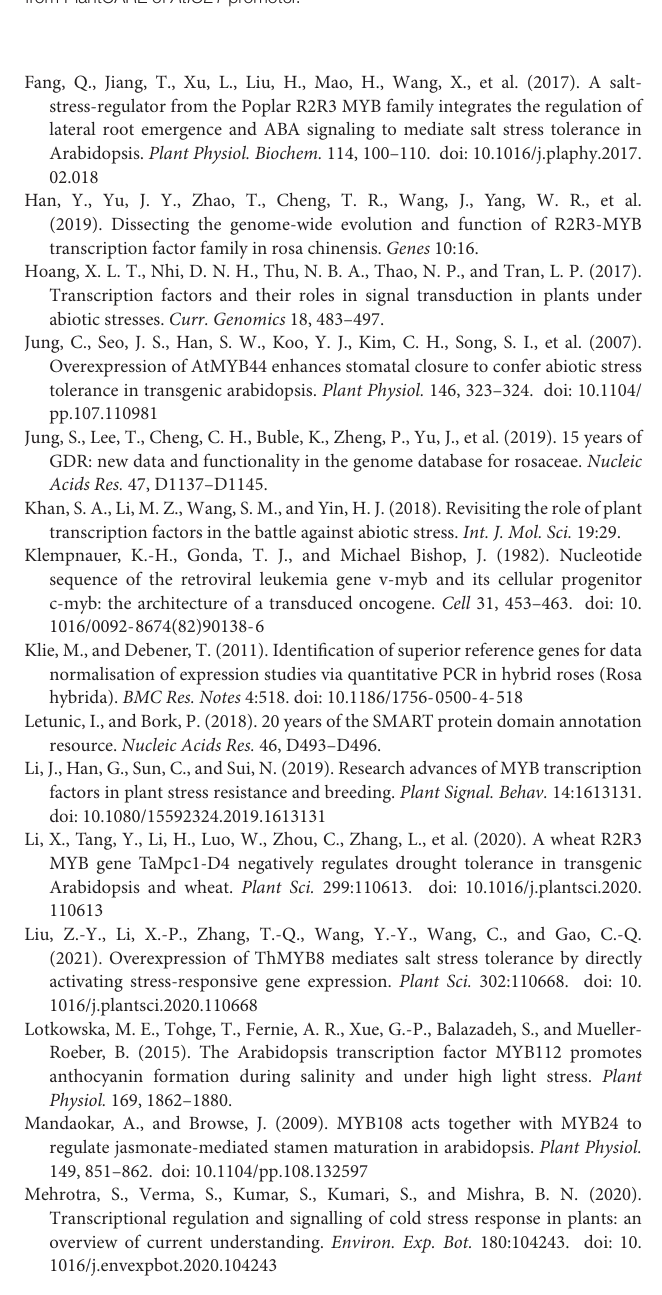
Supplementary Table 2 | The name, raw fragments and fragments per kilobase per million (FPKM) of R2R3-MYBs that respond to low temperature from transcriptome sequencing of Rosa multiflora . Supplementary Table 3 | The subgroups and sequences of 185 RmMYBs from the whole genome of Rosa multiflora . Supplementary Table 4 | The names, nucleotide sequences, and encoded amino acid sequences of 119 R2R3-MYB s in Rosa multiflora . Supplementary Table 5 | The nucleotide and encoded amino acid sequences of R2R3-MYBs in Arabidopsis thaliana from The Arabidopsis Information Resource (TAIR). Supplementary Table 6 | The prediction of sequence and cis -acting elements from PlantCARE of AtICE1